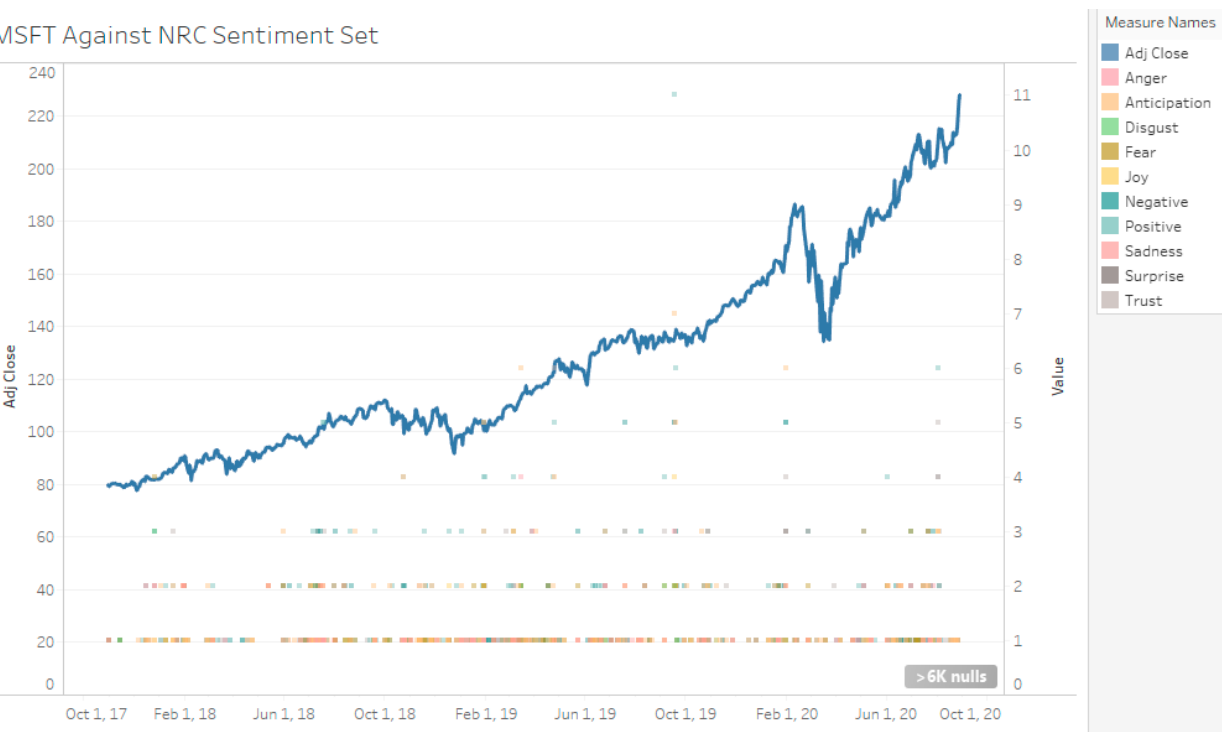
Figure 11. MSFT Stock Against NRC Sentiment.